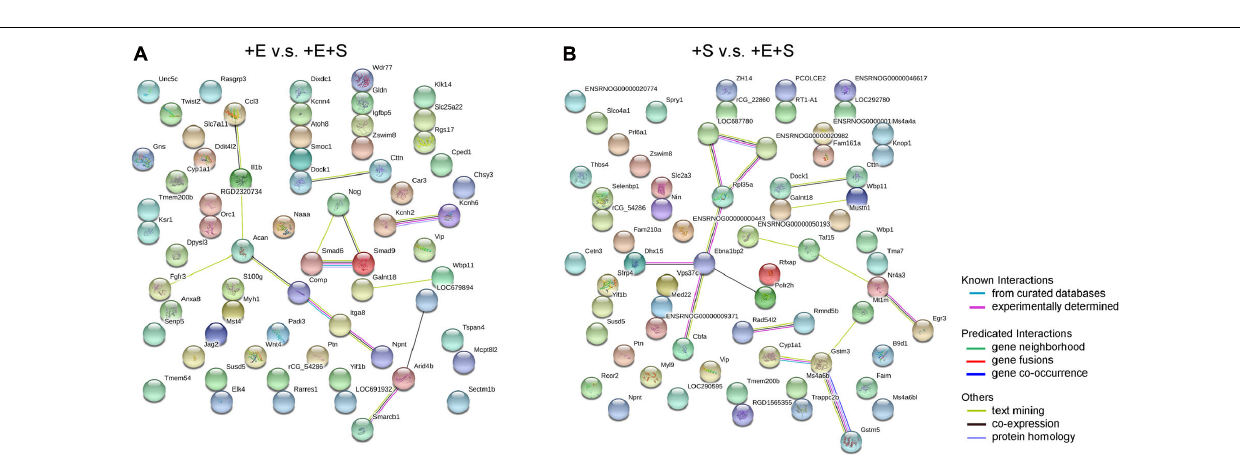
FIGURE 8 | Protein–protein interaction networks by STRING search tool. The up- and downregulated mRNAs (fold change > 1, p < 0.05) network between electrical stimulation with co-stimulation (A) and strain with co-stimulation (B) . Analysis by STRING based on protein–protein interactions. The high confidence score (0.7) was adopted to evaluate the protein interactions for the differentially expressed